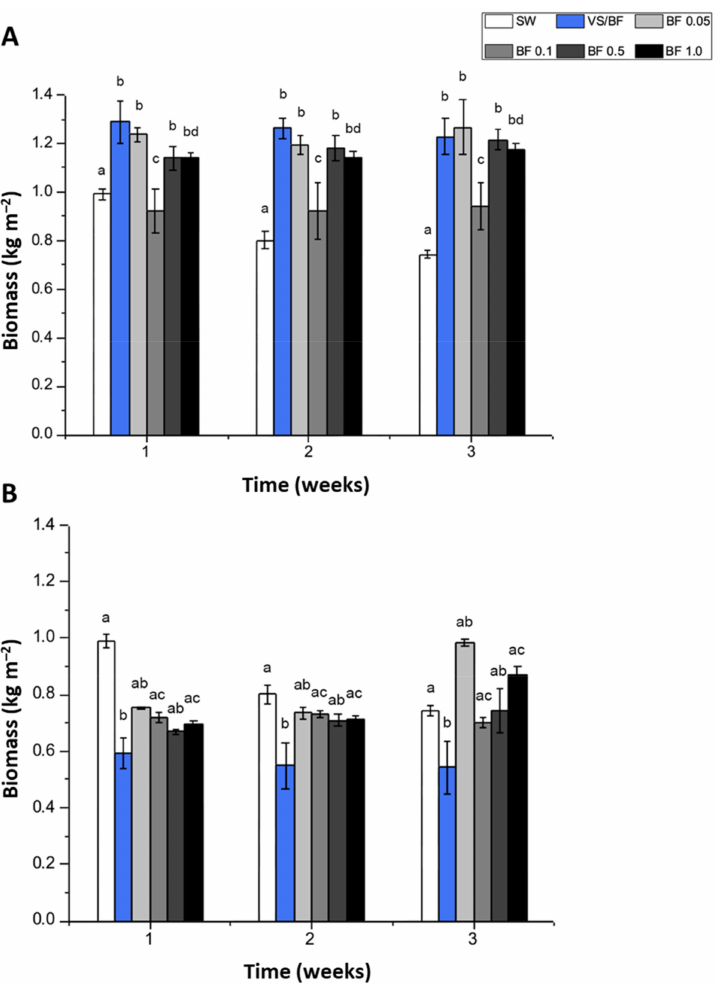
Figure 1. Biomass (kg m –2 ) of G. chilensis obtained under ( A ) indoor and ( B ) outdoor cultivation systems for each treatment evaluated (seawater (SW) treatment or control), Von Stosch/Basfoliar ® Aktiv (VS/BF) treatment, and Basfoliar ® Aktiv (0.05%, 0.1%, 0.5%, and 1% v / v ) treatments) during the three weeks of the experimental period. Values are the mean ± SD of three replicates. The letters above the bar plots indicate the results of Dunn’s tests; means with the same letter are not significantly different at p ≥